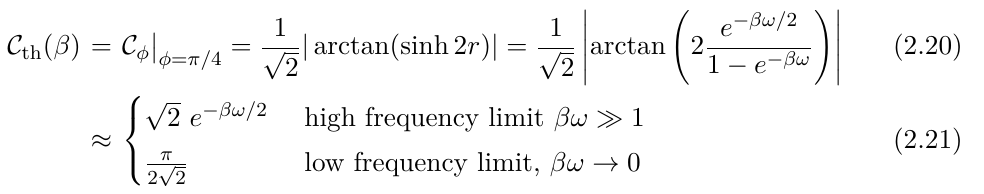
Figure 2. The complexity of purification is minimized by the squeezing angle φ = π/ 4 and has the unique feature that it saturates for low frequencies to C For a fixed temperature T , the minimal thermal complexity of purification C th = C sharply for high frequencies ω > T , as seen in figure